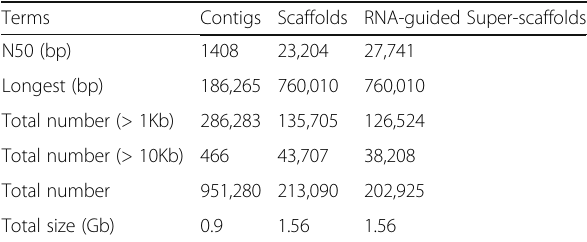
Table 2 Summary of the D. japonica genome assembly